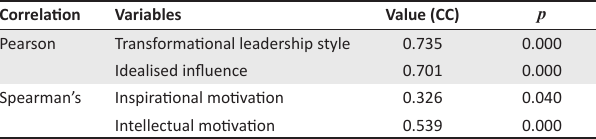
TABLE 6: Self-concept internal motivation and transformational leadership